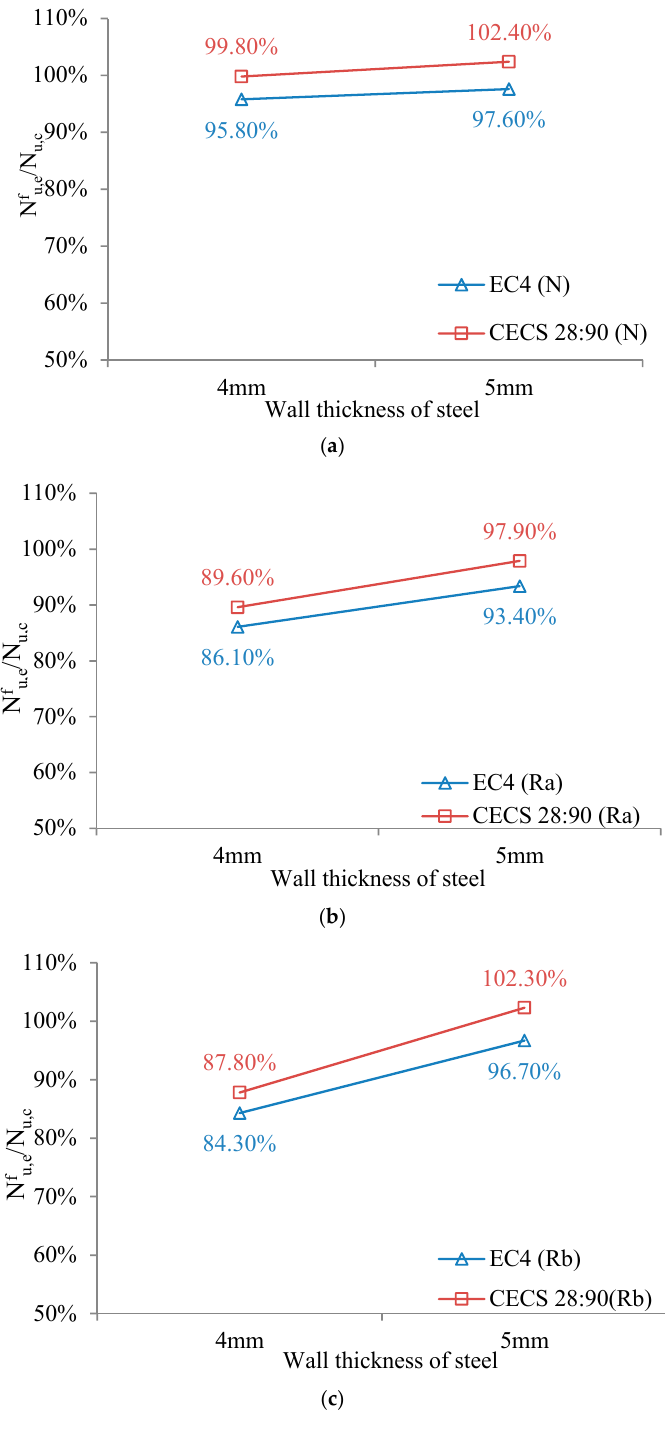
Figure 28. Influence of wall thickness of steel tube. ( a ) Fine aggregate concrete; ( b ) Recycled aggregate concrete (RP RCA = 100%); ( c ) Recycled aggregate concrete (RP RCA = 100% and RP RFA = 100%).